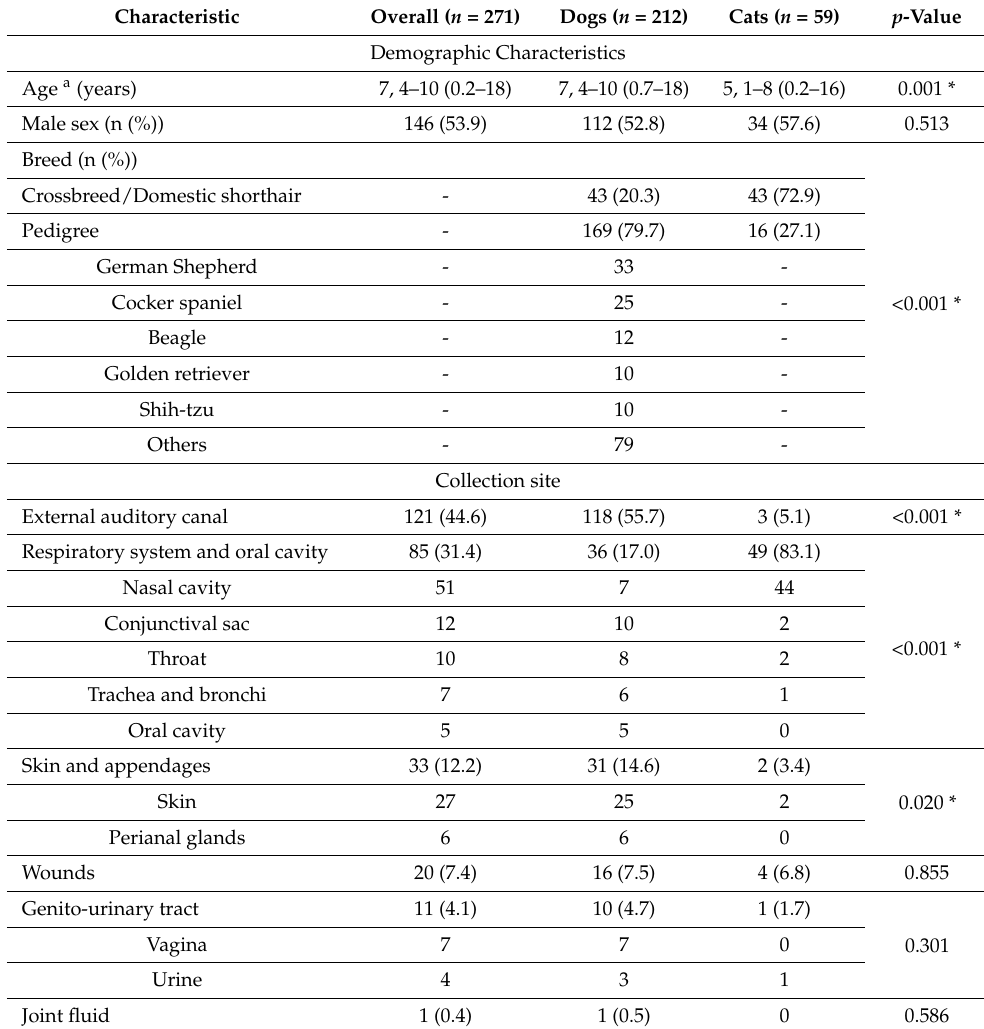
Table 1. Demographic characteristics of the study population and collection sites of P. aeruginosa strains isolated from dogs and